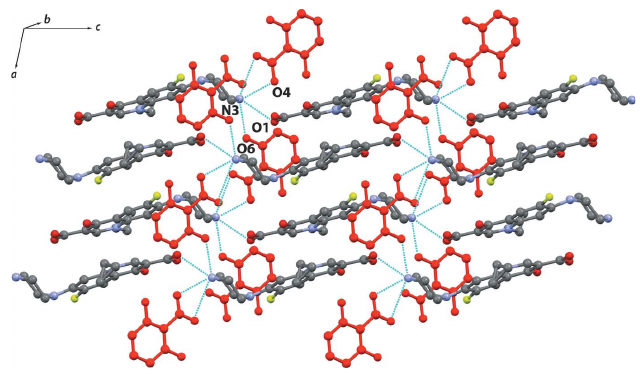
Figure 4 Intermolecular hydrogen-bonding motifs in (I) showing infinite chains along the a- axis direction formed by ciprofloxacin and 2,6HBA (red). Hydrogen atoms are omitted for